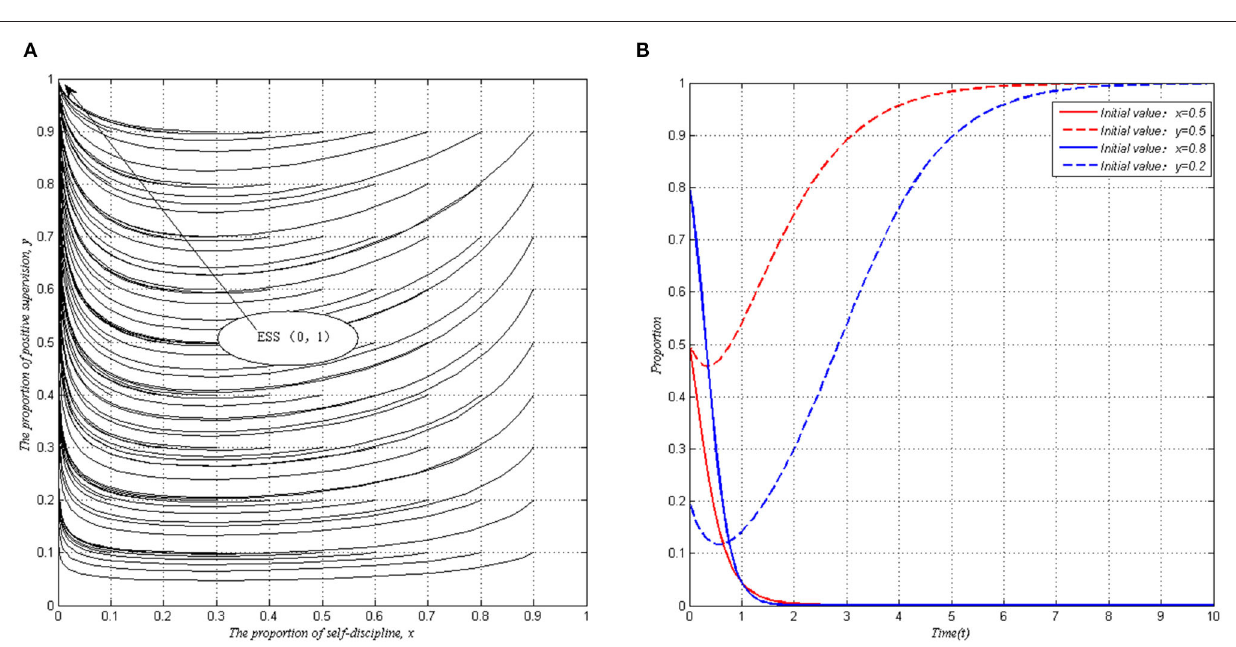
FIGURE 2 | Evolutionary stability of system I when I < P < C